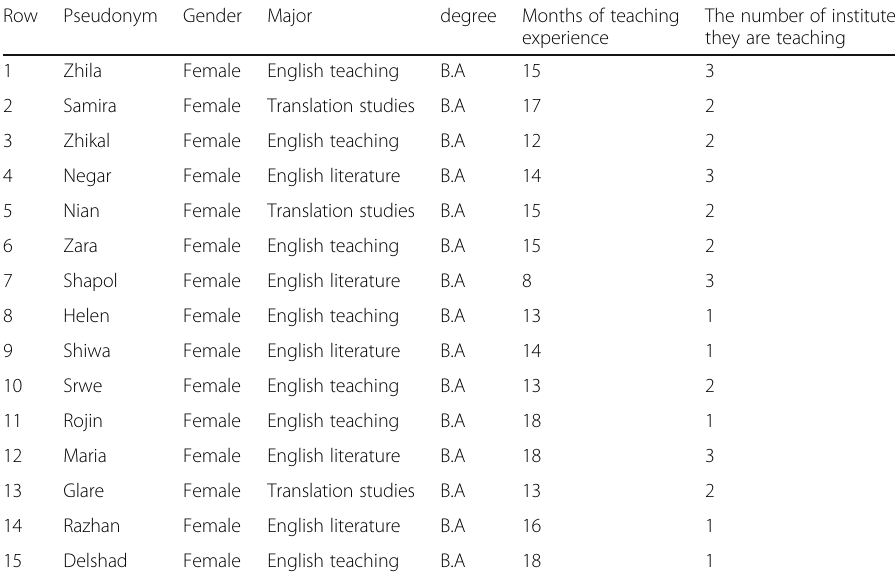
Table 1 Demographic Information of the Participants